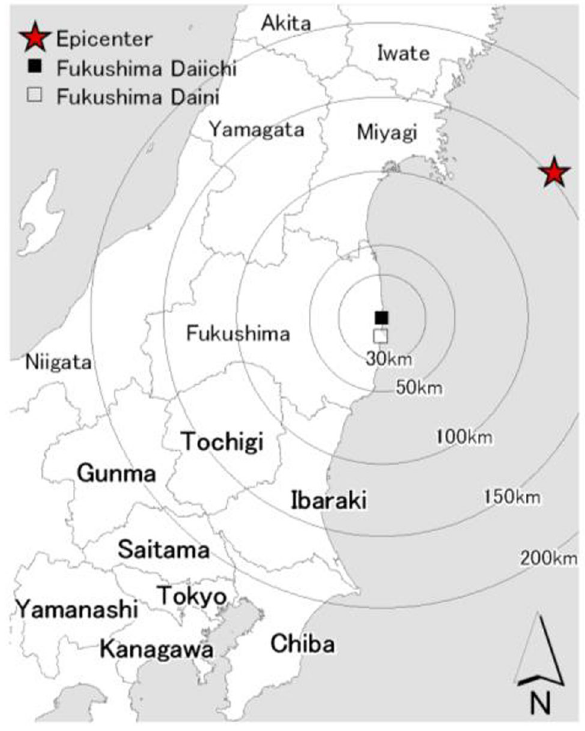
Fig. 1 Map of eastern and northeastern regions of